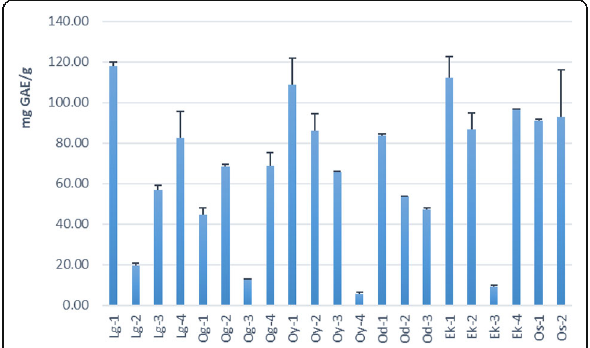
Fig. 1. The percentage flavonoids of the samples ranged from 8.04 ± 0.08 (Oy-3) to 20.07 ± 0.21 (Os-2) with just 2 samples having a value smaller than 10%. It showed